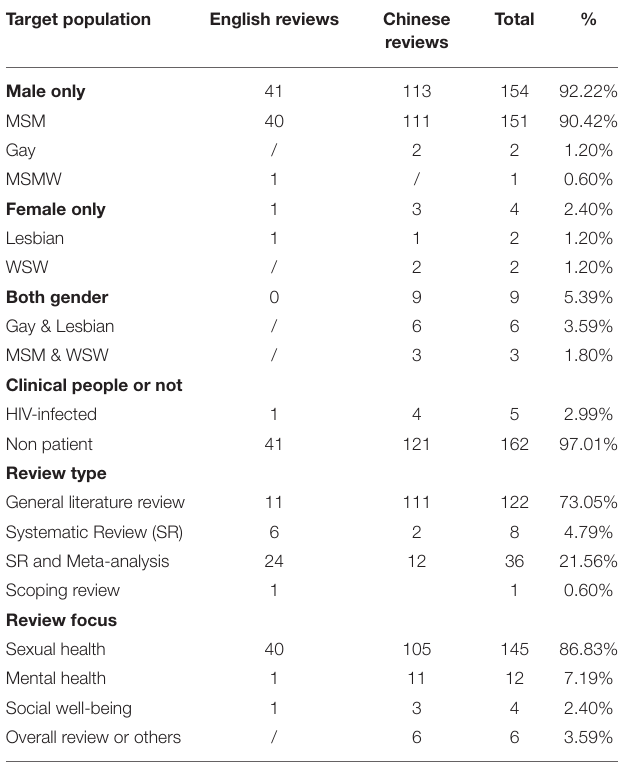
TABLE 2 | Characteristics of the included